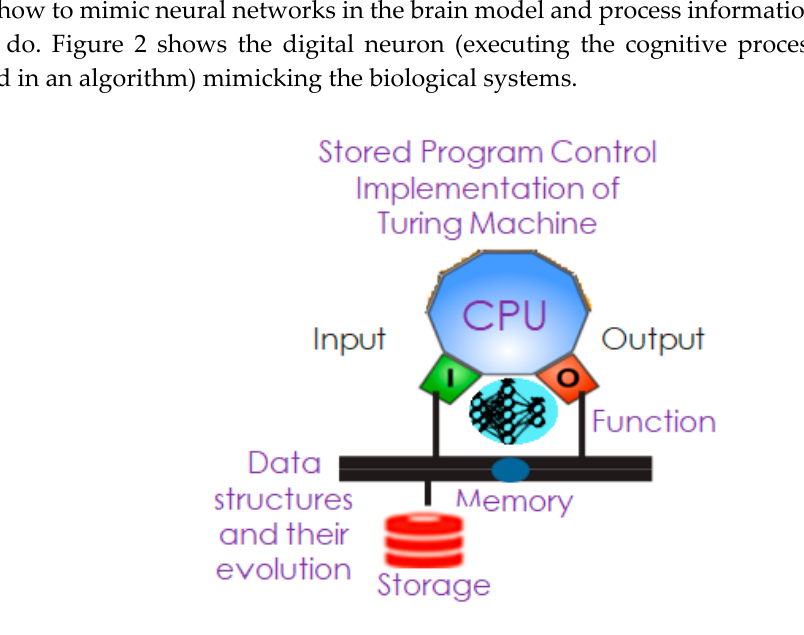
Figure 2. Digital Neuron—a cognitive apparatus executing the processes that cannot be specified as a sequence of tasks but encoded in neural network